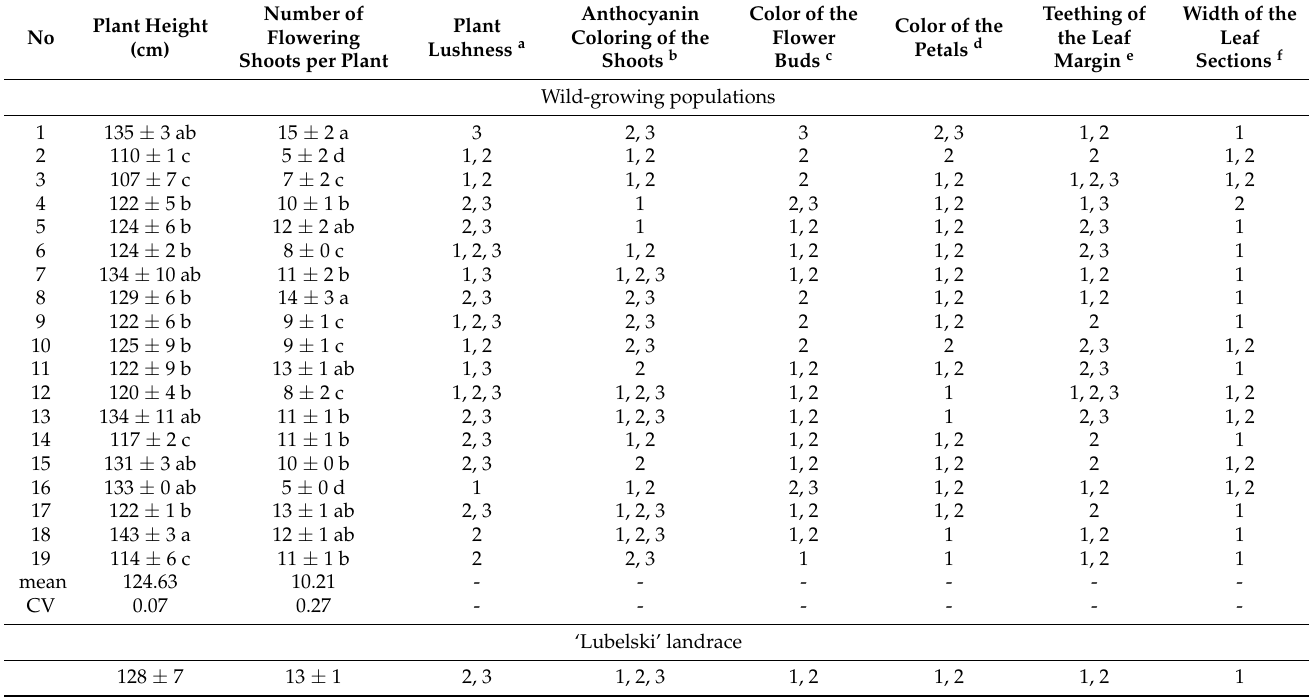
Table 2. Characteristics of the common valerian population’s aboveground organs.